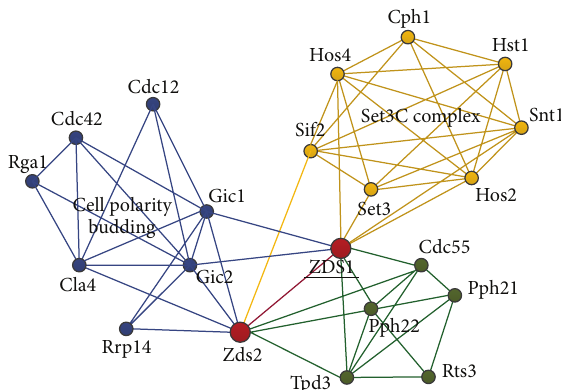
Figure 1: The community structure of Protein reaction network.